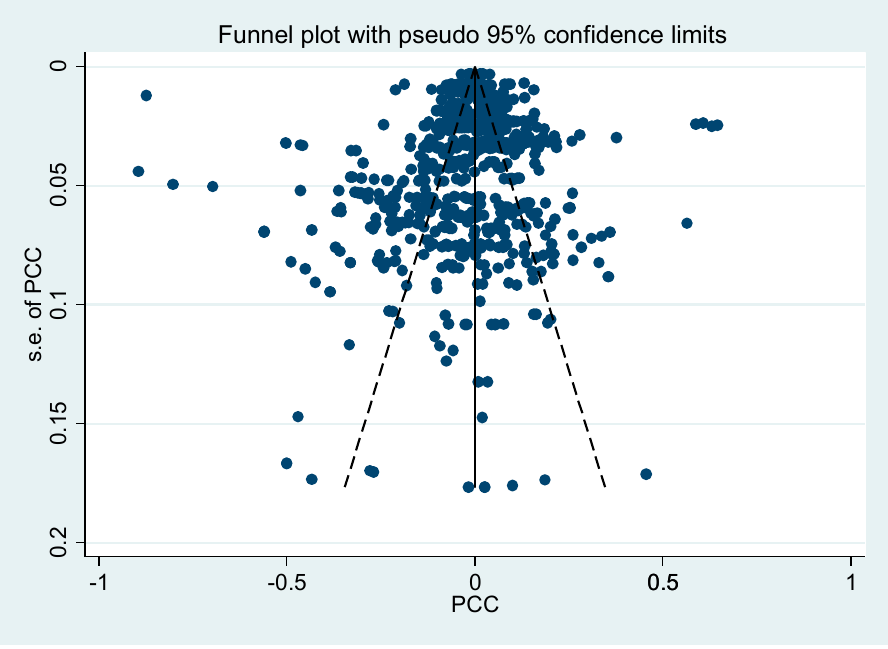
Figure 2. Funnel plot of standardized effects of capital on risk (PCC). Note: The vertical line shows the estimation of the population effect size. The two diagonal lines are the 95% confidence interval of the estimation.